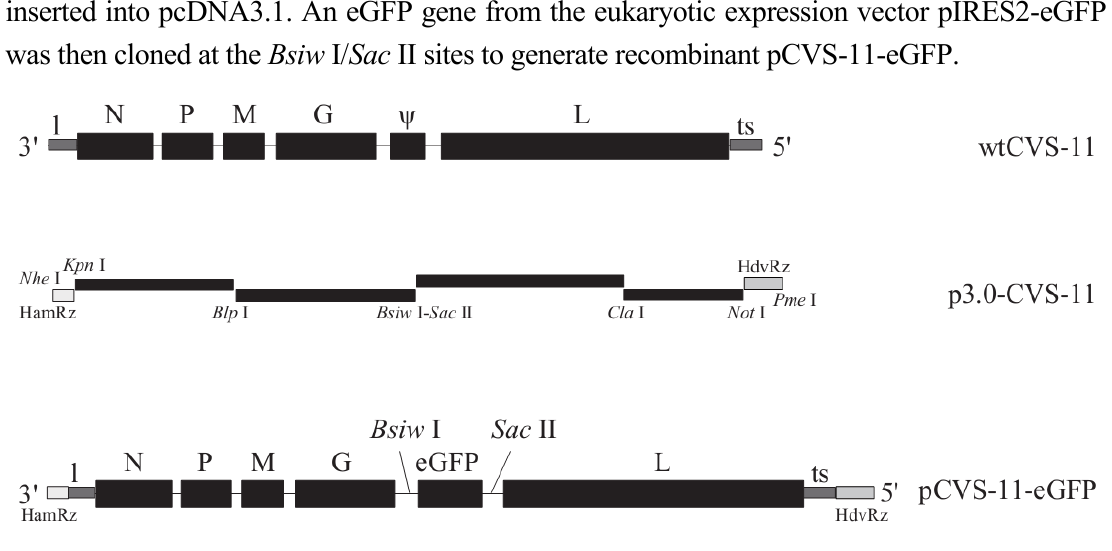
Figure 1. Schematic construction of the full-length cDNA recombinant plasmid.